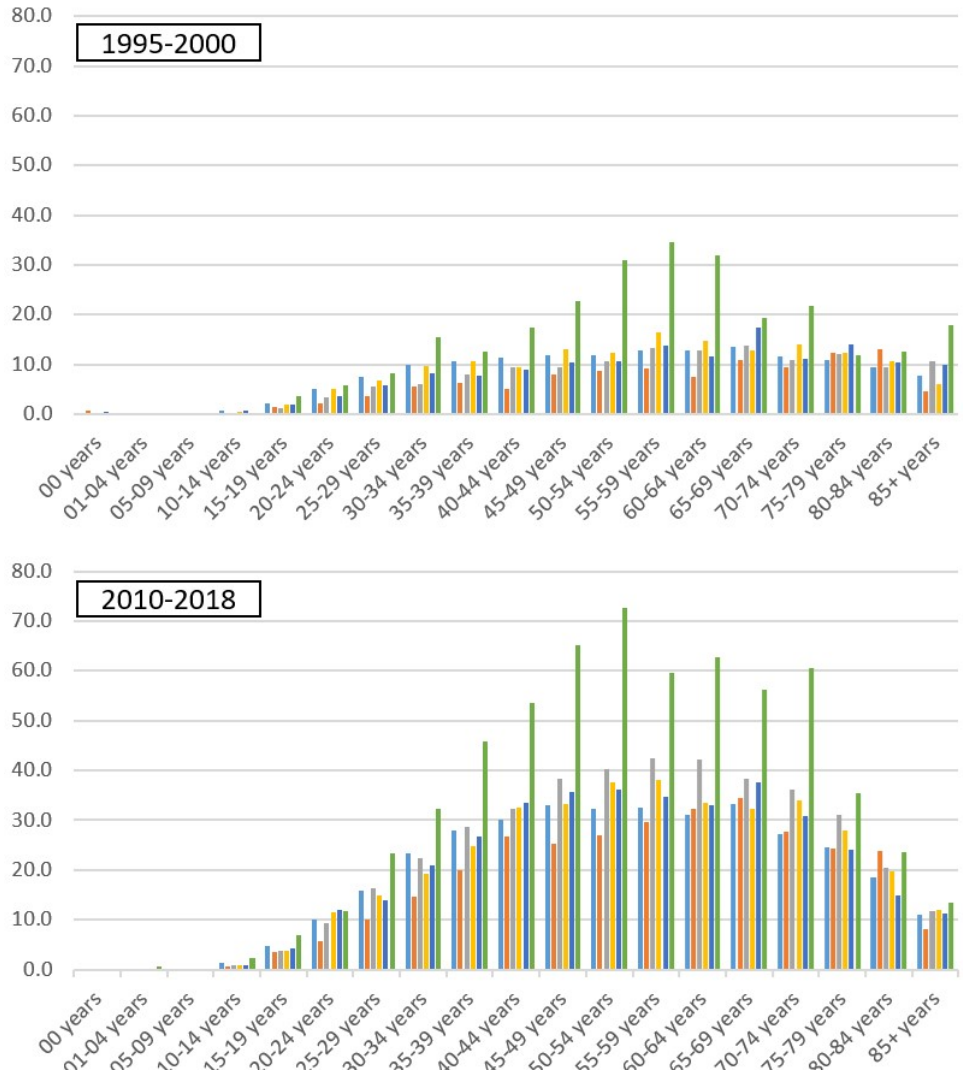
Figure 3. Age-adjusted thyroid cancer incidence rates per age group for the NYC boroughs and NYS excluding NYC for 1995–2000 and 2010–2018.